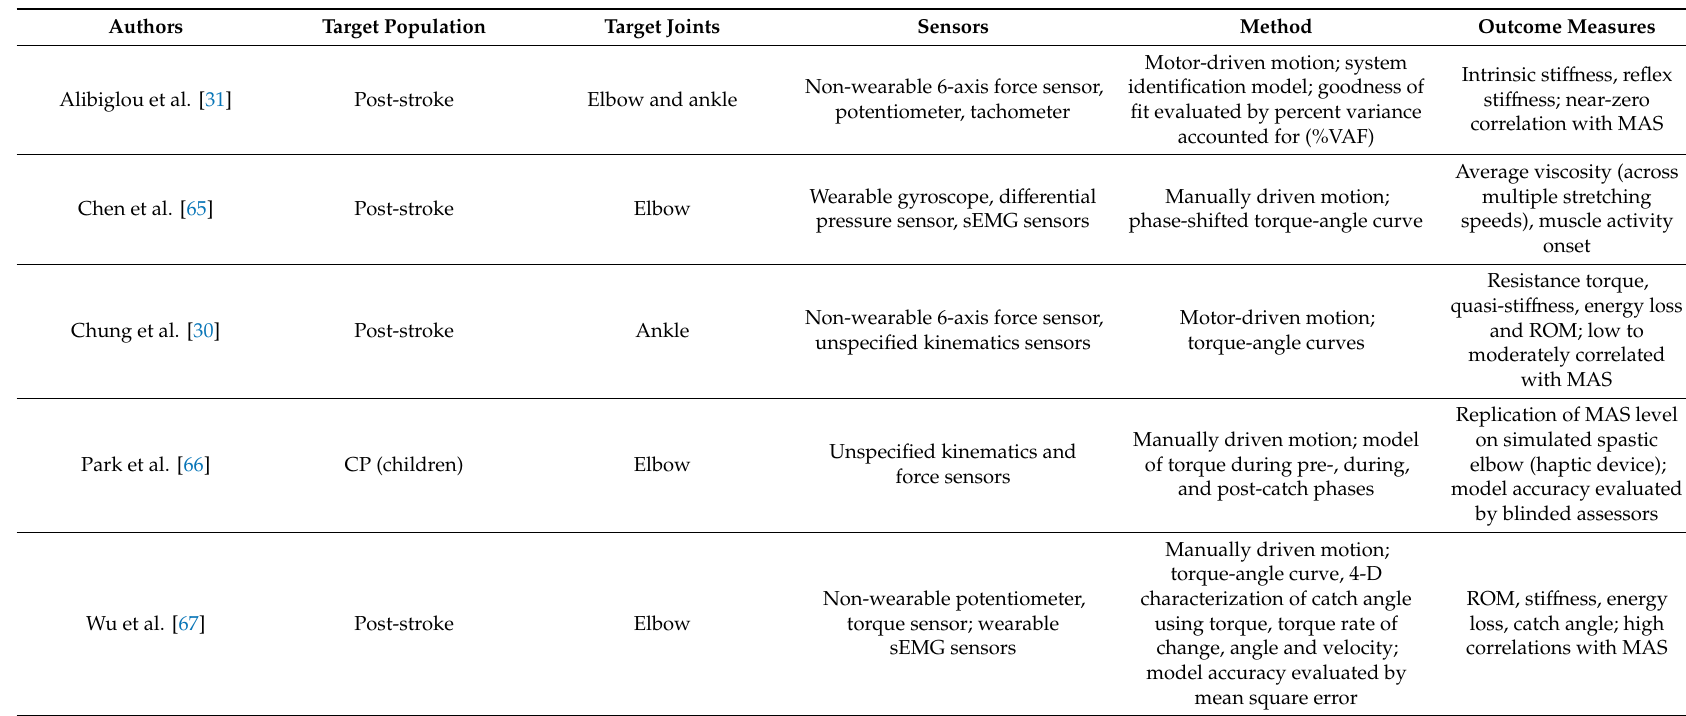
Table 2. Reviewed mechanical approaches to modeling